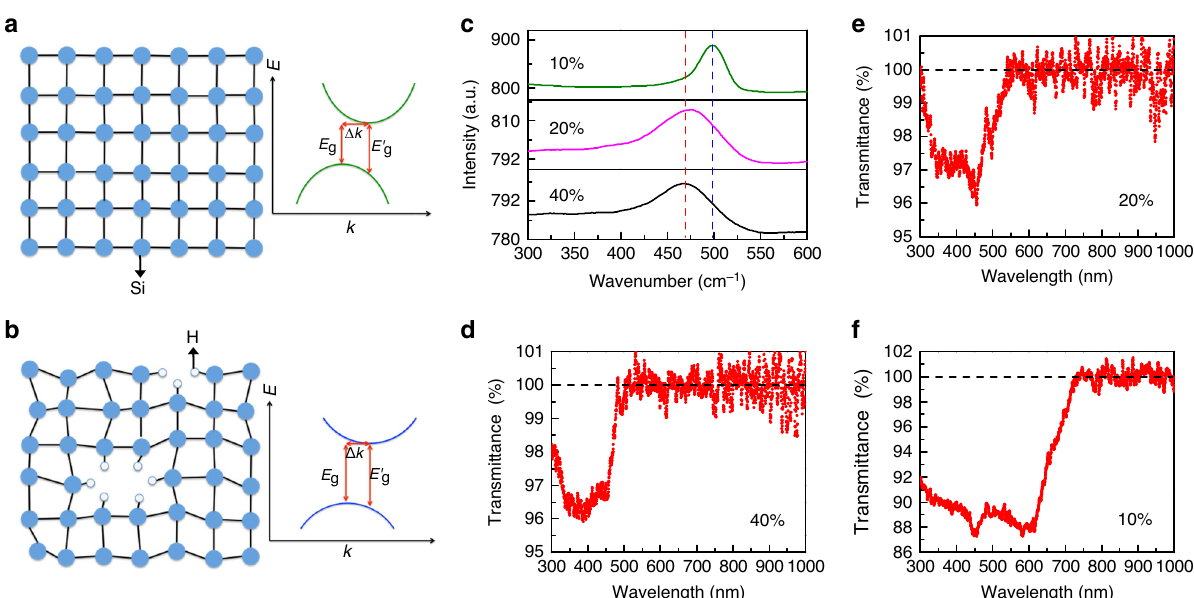
Fig. 1 Bandgap engineering of low-loss hydrogenated a-Si nanoparticles. a , b Two-dimensional schematic representations of the atomic arrangement and the bandgap of c-Si ( a ) and a-Si:H ( b ). E is the energy, and k is the wave vector. E g is the indirect bandgap, E g ′ is the direct transition, and Δ k is the wave- vector mismatch. c Raman spectra of a-Si:H NPs with 40, 20, and 10% of hydrogen. The blue dashed line indicates the peak position of 495 cm − 1 , and the red dashed line labels the peak position of 470 cm − 1 . d – f Transmission spectra of a-Si:H NP(40) ( d ), a-Si:H NP(20) ( e ), and a-Si:H NP(10) ( f ) in ethanol after removing scattering